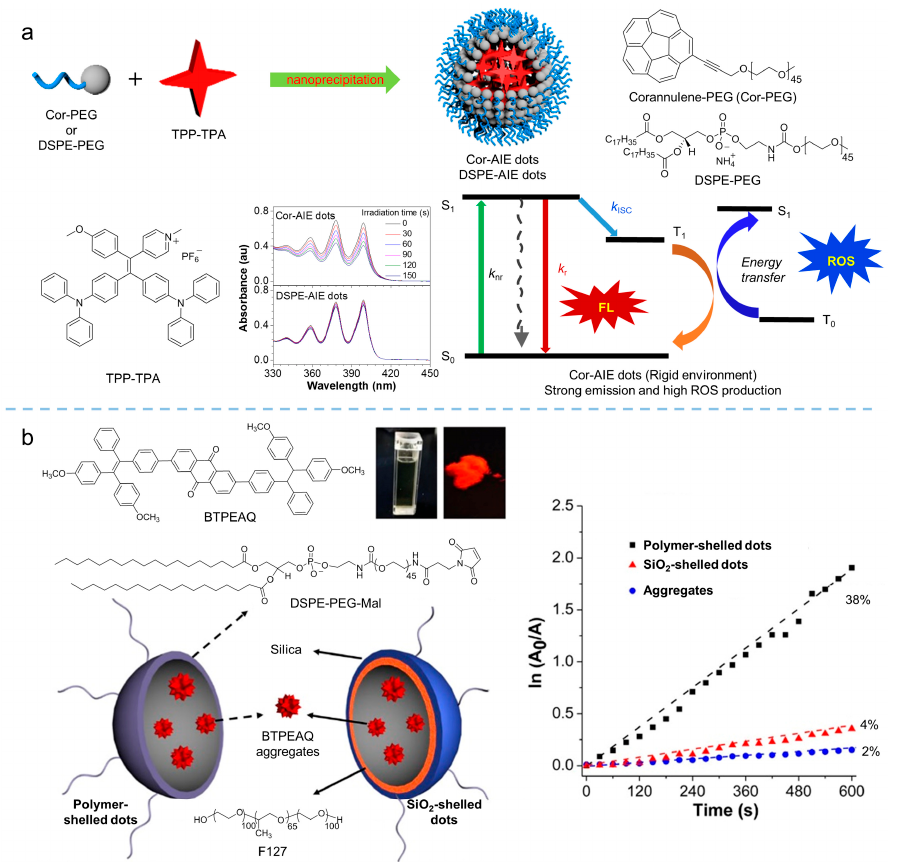
Figure 13. Aggregation microenvironment strategies to promote ROS production. ( a ) Schematic illustration of the construction of the Cor-AIE dots and DSPE-AIE dots with the photosensitizer of TPP-TPA. ROS generation from the flexible (DSPE-AIR points) and rigid (core points) aggregation environment, and the mechanism illustration of ROS manipulation. Reprinted with the permission of the authors of [73]. Copyright 2018, Wiley-VCH GmbH. ( b ) Molecular structure of BTPEAQ and schematic illustration of polymer and SiO 2 -shelled dots; degradation of ABDA by BTPEAQ along with increased irradiation time. Reprinted with the permission of the authors of [74]. Copyright 2016, American Chemical Society.